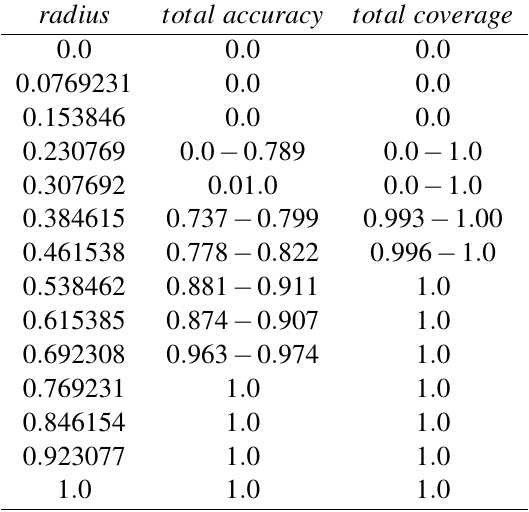
Table 3. Effect of a choice of a granular covering on classifica-